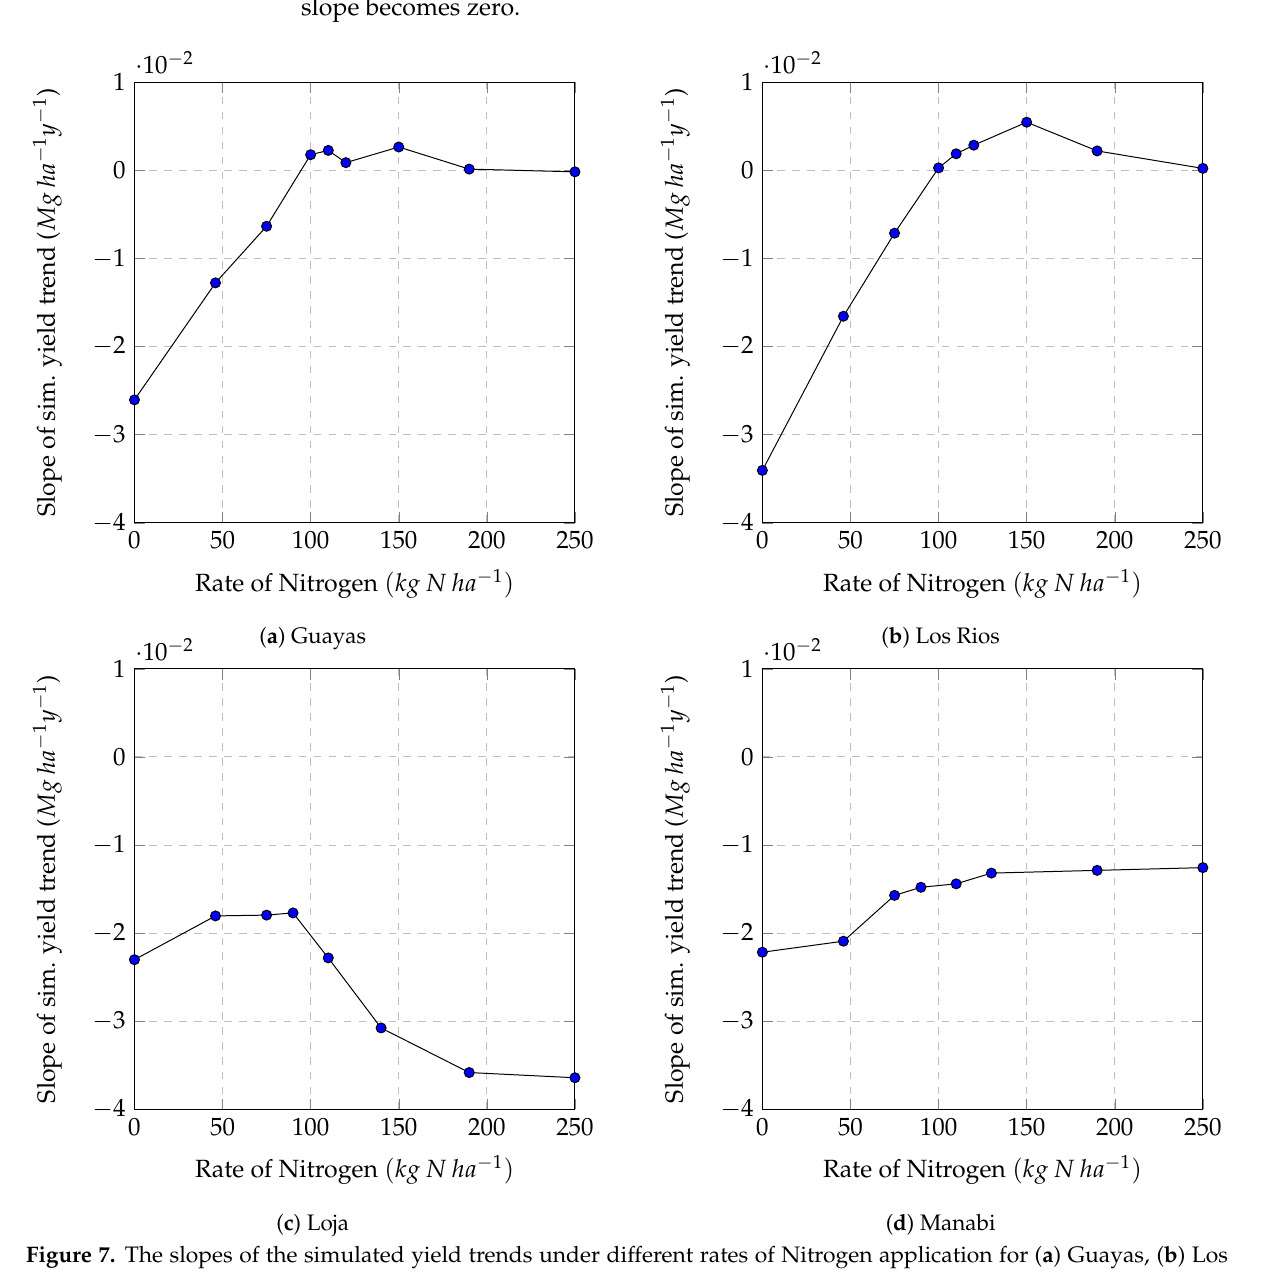
Figure 7. The slopes of the simulated yield trends under different rates of Nitrogen application for ( a ) Guayas, ( b ) Los Rios, ( c ) Loja and ( d ) Manabi. Each dot represents the value of the slope (Mg ha − 1 year − 1 ) of each scenario of nitrogen application. At lower rates of nitrogen application (<150), the effect is due to the loss of soil fertility and climate change and, at higher rates of nitrogen application (>150), the effect is mainly due to climate